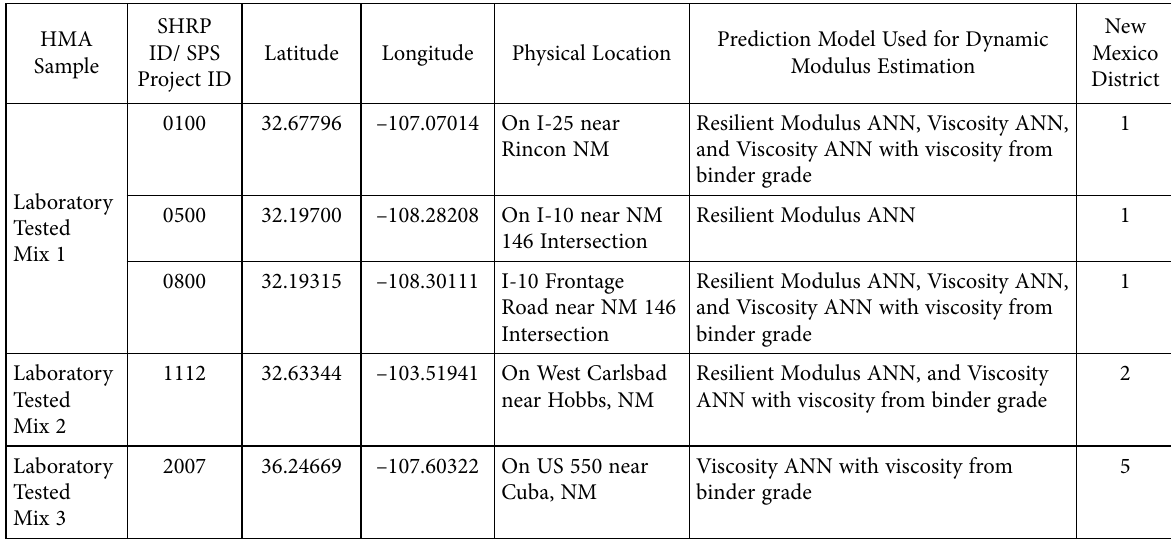
Table 1. Selected LTPP sections and their physical locations